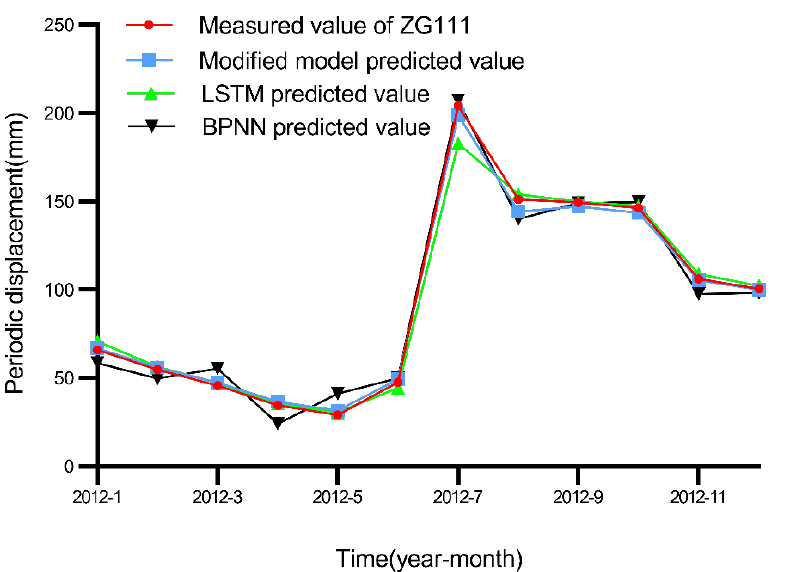
Figure 23. Periodic displacement predicted results of ZG111 using LSTM-FC, LSTM and BPNN models.